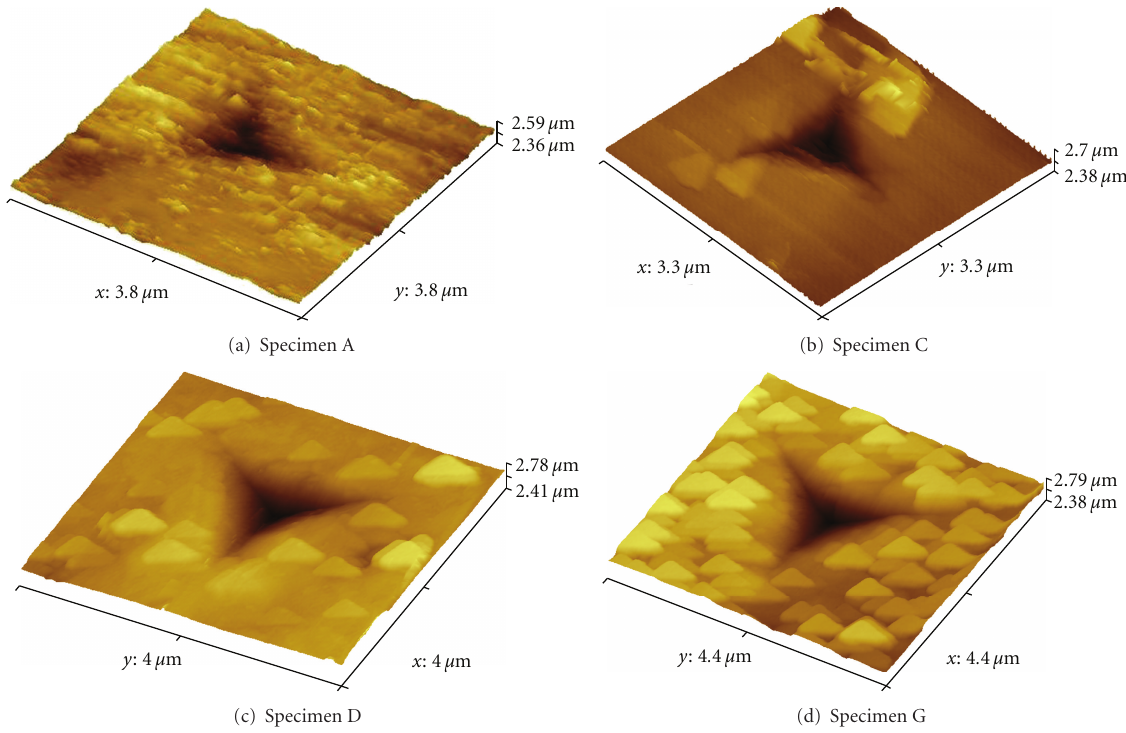
Figure 9: AFM images showing what could possibly be clusters of nanoparticles embedded in the samples synthesized by fluorine-ion-beam implantation, (a) unimplanted specimen A, and ((b)–(d)) fluorine-implanted specimens C, D, and